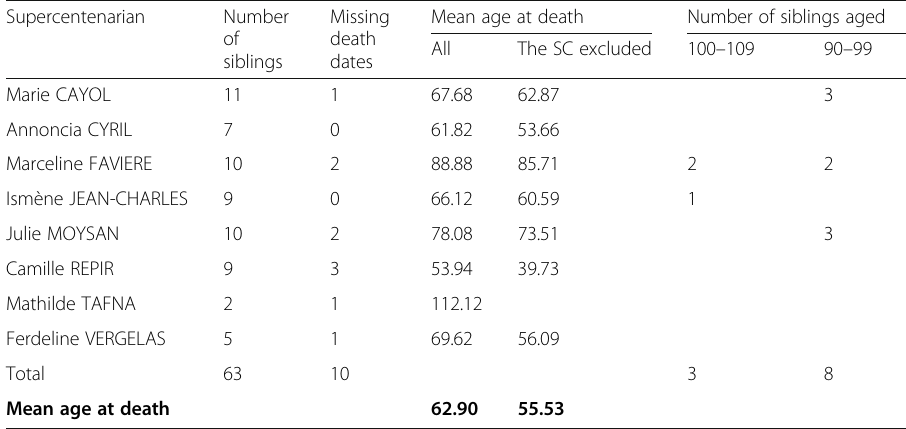
Table 6 Lifespan indicators in the sibship of the eight Guadeloupean supercentenarians